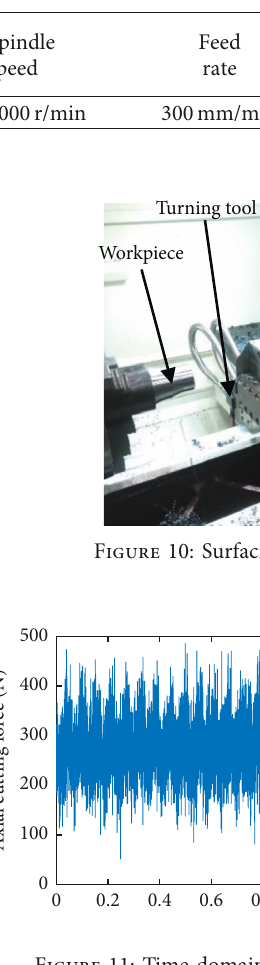
Figure 11: Time domain signal of axial cutting force.